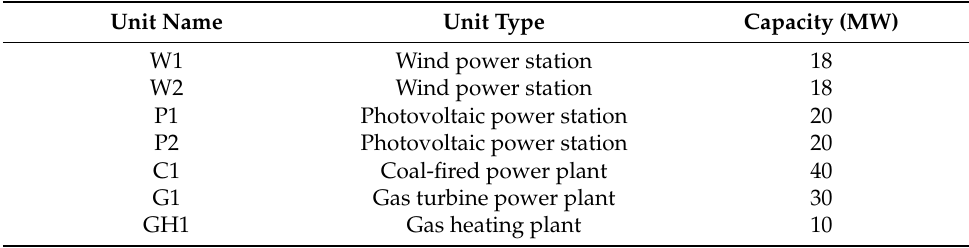
Table 1. Power plant parameters.